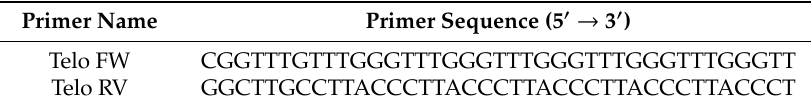
Table 1. Telomeric primers used for qPCR detection.